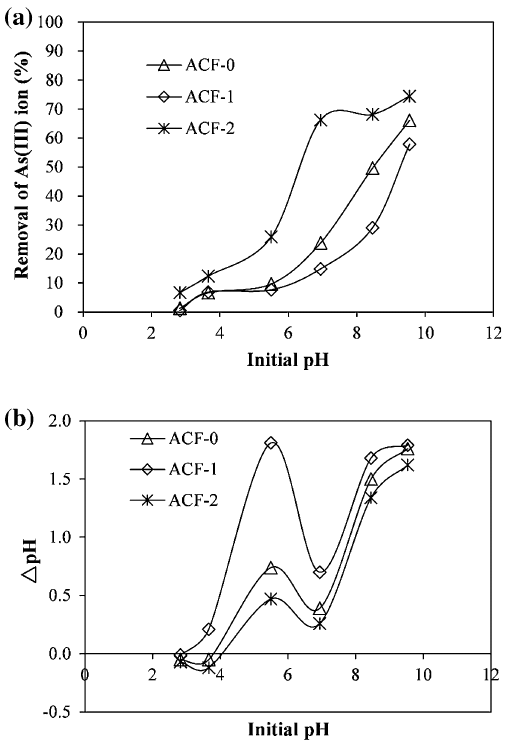
Fig. 6 Linearized adsorption isotherms of As (III) by ACF-0, ACF-1 and ACF-2: Langmuir ( a ) and Freundlich ( b ). Dosages of absorbents were 500 mg/L; reaction time was 300 min, and the initial pH was